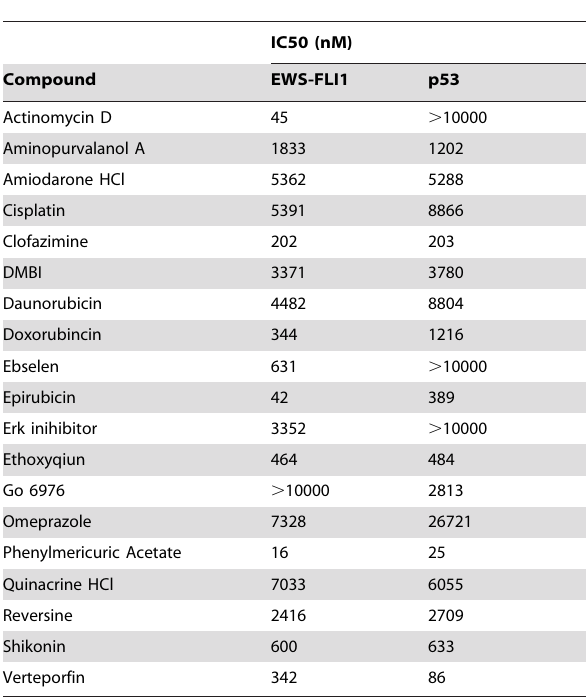
Table 1. AlphaScreen